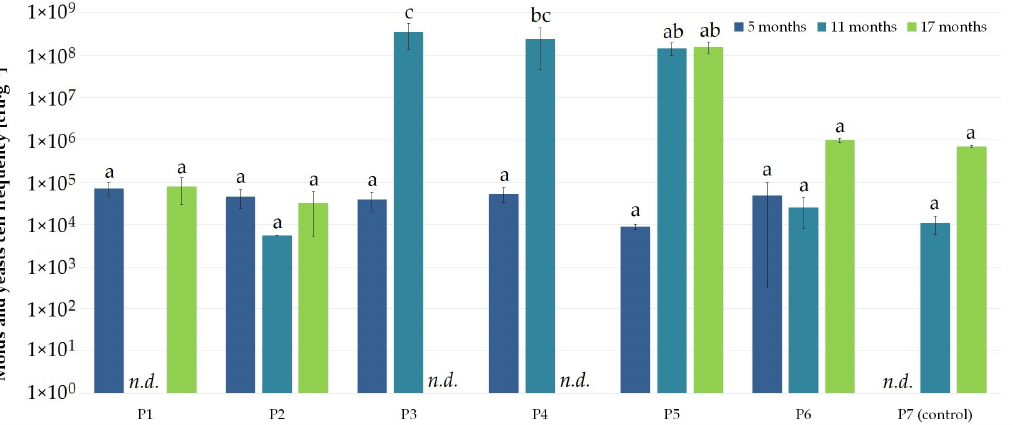
Figure 3. Mold and yeast population changes in silage during the first experimental stage. Storage time: 5, 11 and 17 months. Bars marked with the same letters indicate no statistical difference ( p < 0.05); n.d.— not detectable.